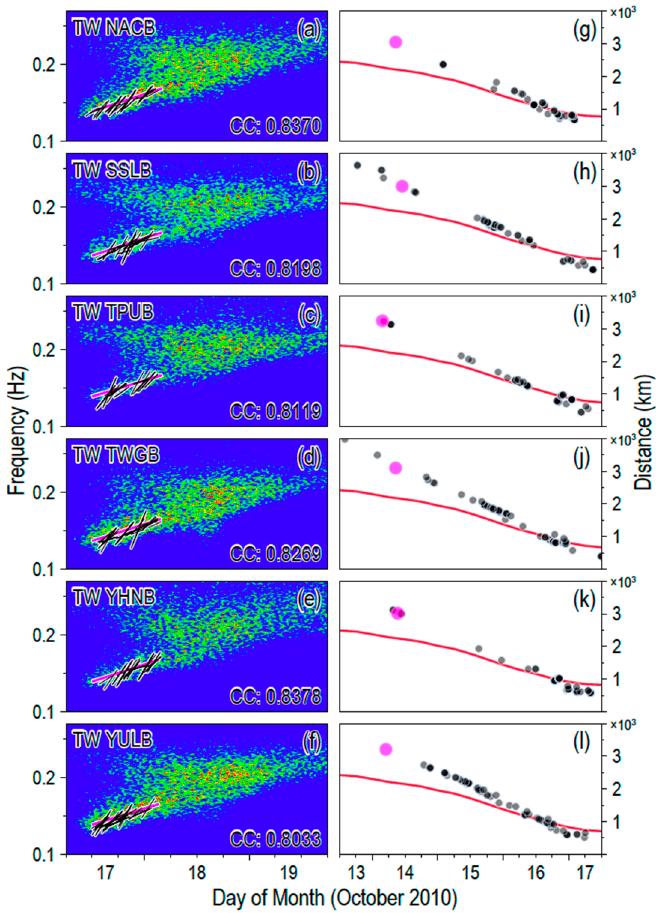
Figure 5. Estimation of the propagation distance x of typhoon-induced swells from the origin to the Taiwan coastline based on seismic records. ( a – f ) Dispersive DF microseisms generated by the ocean swells induced by Typhoon Megi on power spectrograms computed using data from seismic stations in Taiwan. The pink solid lines superimposed on the spectrograms represent least-squares regression lines as in Figure 3b, and dark lines denote the calculated slope df / dt of the dispersive DF microseisms in successive three-hour time windows. ( g – l ) Comparison between estimated propagation distances of typhoon-induced swells and distances from the typhoon center to seismic stations (red lines). Large pink dots and small gray dots represent calculated propagation distances using the pink and dark lines in the subfigures in the left column, respectively.